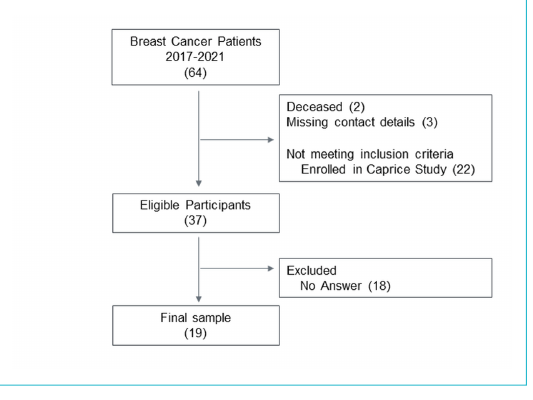
Figure 1: Patient flow diagram. Numbers in brackets indicates number of